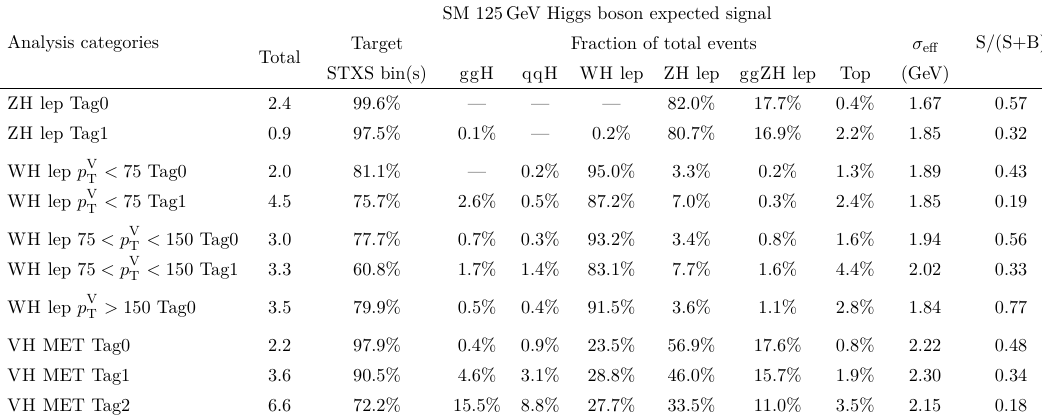
= 125 GeV in analysis categories targeting Table 7 . The expected number of signal events for m H Higgs boson production in association with a leptonically decaying W or Z boson, shown for an integrated luminosity of 137 fb − 1 . The fraction of the total number of events arising from each production mode in each analysis category is provided, as is the fraction of events originating from the targeted STXS bin or bins. Entries with values less than 0.05% are not shown. Here ggH includes contributions from the ggZ(qq)H and bbH production modes, qqH incorporates both VBF and VH production with hadronic vector boson decays, and “Top” represents both ttH and tH production together. The σ , defined as the smallest interval containing 68.3% of the m eff gg distribution, is listed for each analysis category. The final column shows the expected ratio of signal to signal-plus-background, S/(S+B), where S and B are the numbers of expected signal and background events in a ± 1 σ window centred on m eff H